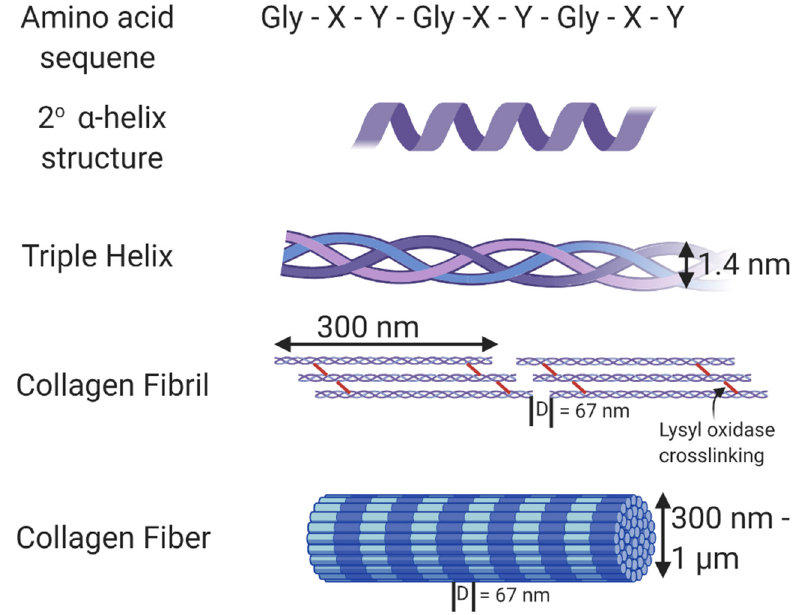
Figure 1. Structure of collagen. The amino acid sequence of collagen consists of Gly-Xaa-Yaa repeats, with Xaa and Yaa commonly occupied by proline and hydroxyproline. This unique sequence allows collagen to form an α helix secondary structure. Fibrillar collagen is a triple helix containing crosslinks formed through the action of lysyl oxidase. In vivo, these collagen fibrils form fibers with varying thickness and a D-banding pattern of 67 nm. Made using Biorender.